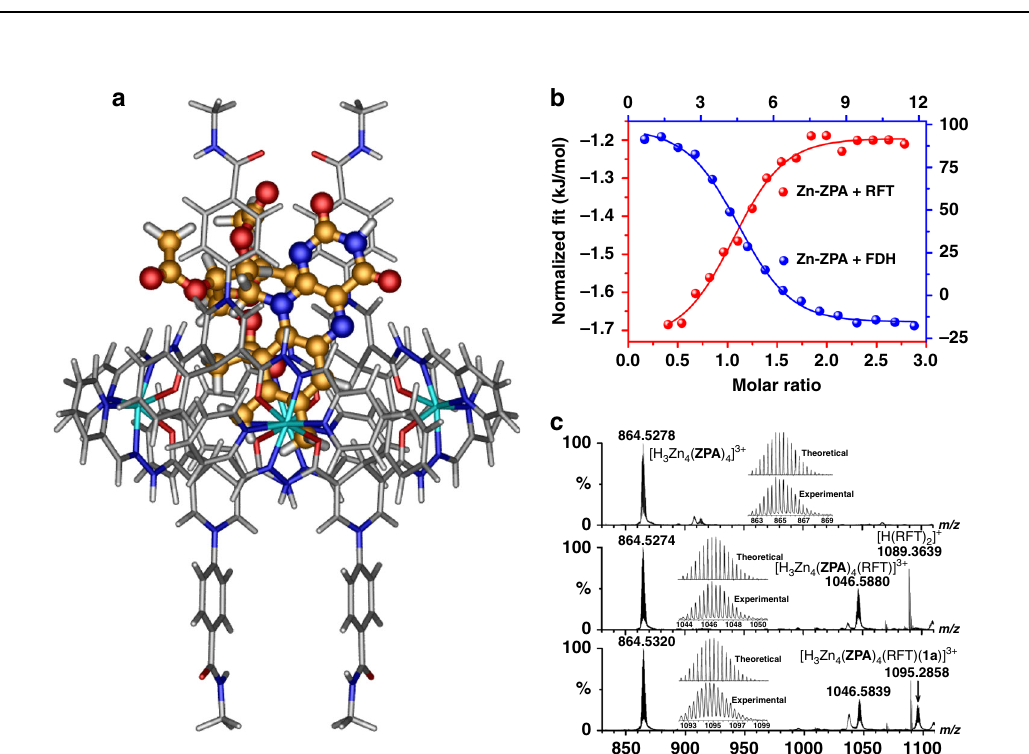
Fig. 4 Characterization of the host – guest behavior between Zn – ZPA and RFT or FDH. a Representation of the encapsulation of Zn – ZPA and RFT computed by the theoretical ‘ docking study ’ calculations. b ITC experiments on Zn – ZPA upon the addition of RFT or FDH showing the formation of host – guest complexes in CH 3 CN/H 2 O (2:1). c ESI-MS spectra of Zn – ZPA (top), Zn – ZPA (middle) following the addition of 1 equiv of RFT and Zn – ZPA (bottom) following the addition of 1 equiv of 1a and RFT in CH 3 CN solution. The insets show the measured and simulated isotopic patterns at m / z = 864.5278, 1046.5880 and